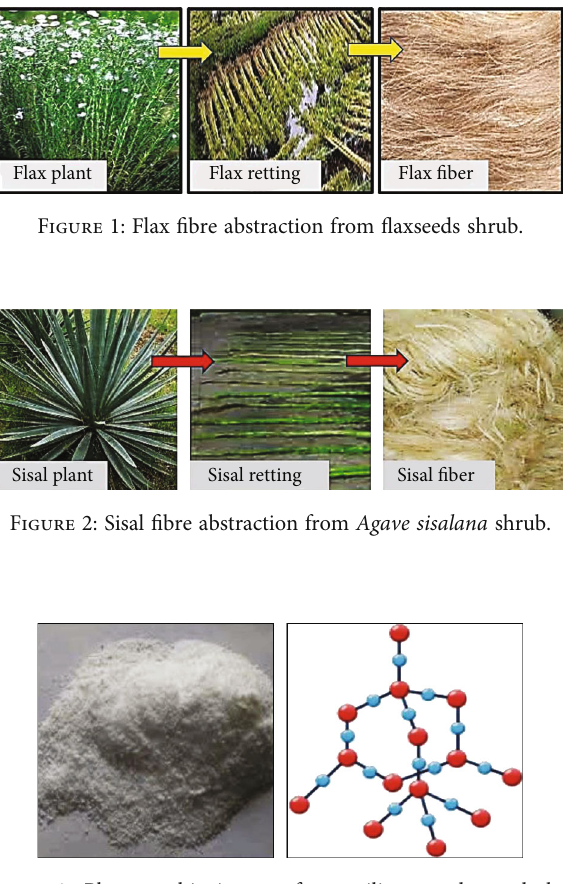
Figure 3: Photographic image of nanosilica powder and their chemical structure.